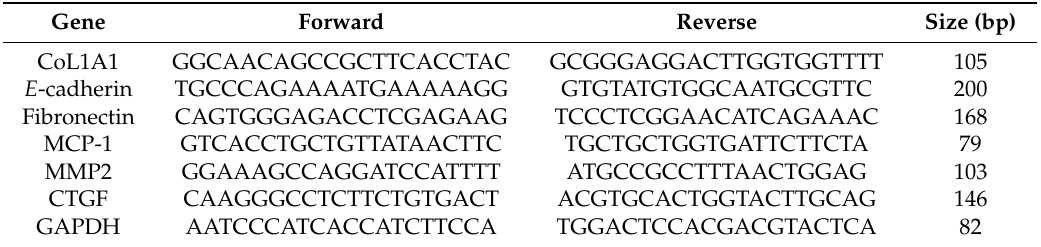
Table 1. RT-PCR primer